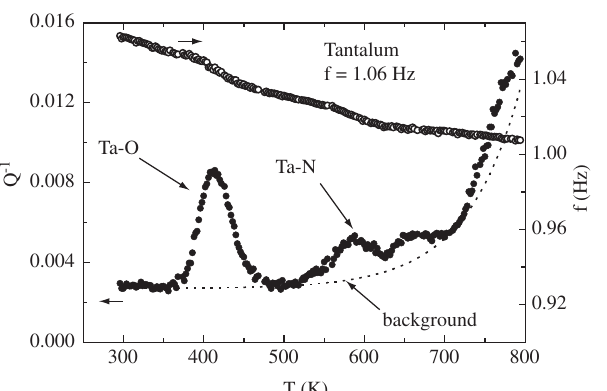
Figure 4. Frequency influence on internal friction for Ta-O relaxation